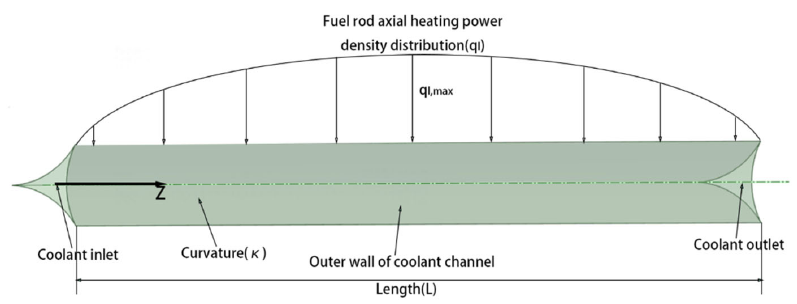
Figure 6. Numerical model validation by Chen et al. [19].